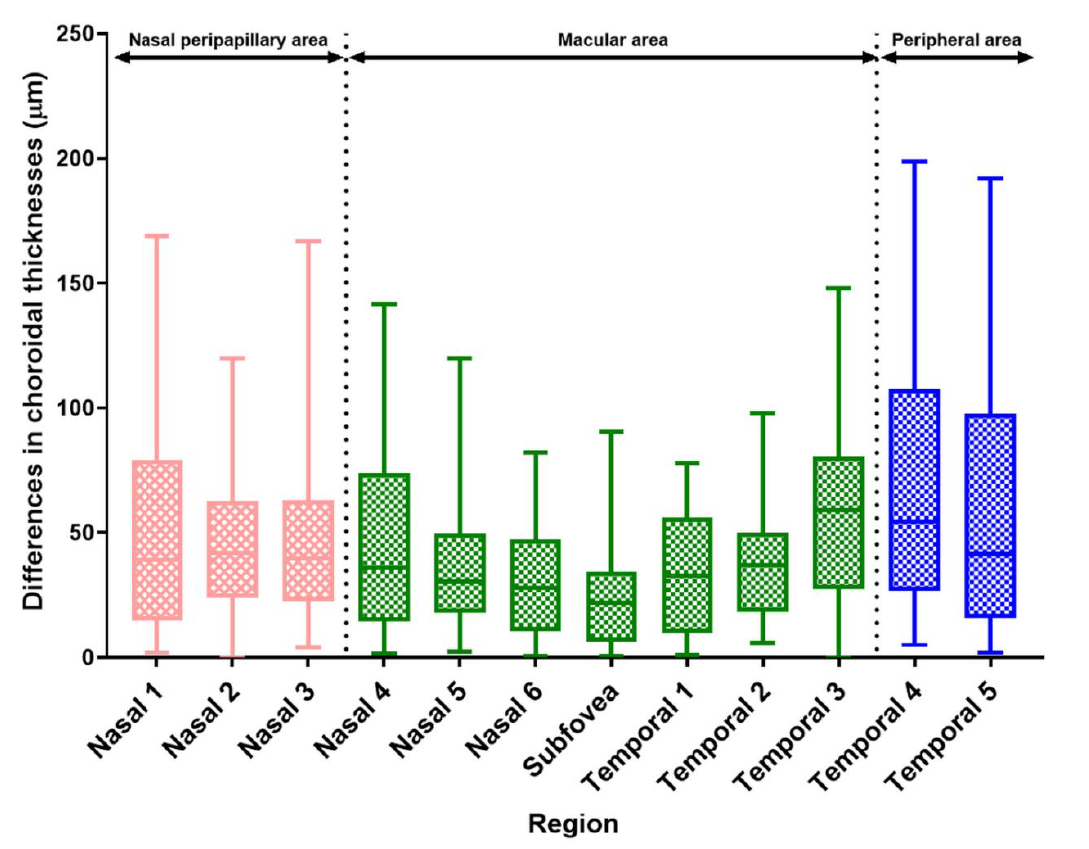
Figure 3. Box and whisker plots (2.5–97.5 percentile) of absolute interocular differences in CT according to region. CT differences were generally greater in the nasal peripapillary and peripheral areas than in the macular area. CT: choroidal thickness. The mean absolute difference in CT increased gradually from the macular to the nasal peripapillary and peripheral areas (38.42 ± 28.59, 48.17 ± 34.60, and 63.36 ± 50.54 µ m, Table 4. Interocular difference in CT among the nasal peripapillary, macular, and peripheral areas. respectively; p < 0.001, one-way ANOVA). In the Bonferroni post hoc test, the Region